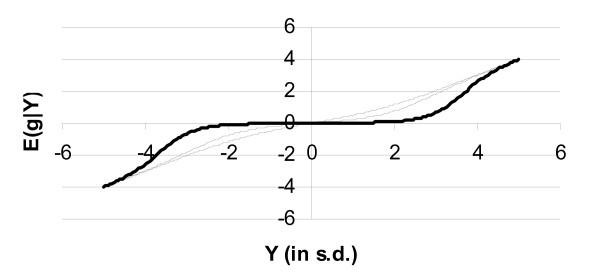
The expectation of the genetic value given the summary statistic of the data Y, E(g|Y) as a function of Y. The parameter of the exponential distribution is λ = 1, σ2 = 1, and the probability of a marker having a true effect is γ = 0.05 (bold curve), 0.5 (dotted curve), and 1.0 (regular line).